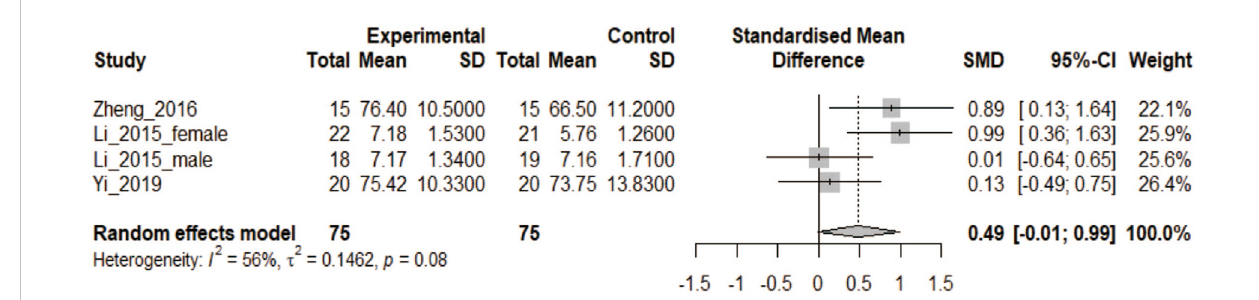
FIGURE 5 In the comparative study of 3DPs vs. 3DI, the combined data were used to compare the test scores of the two groups after training. (3DI: 3D visual imaging).